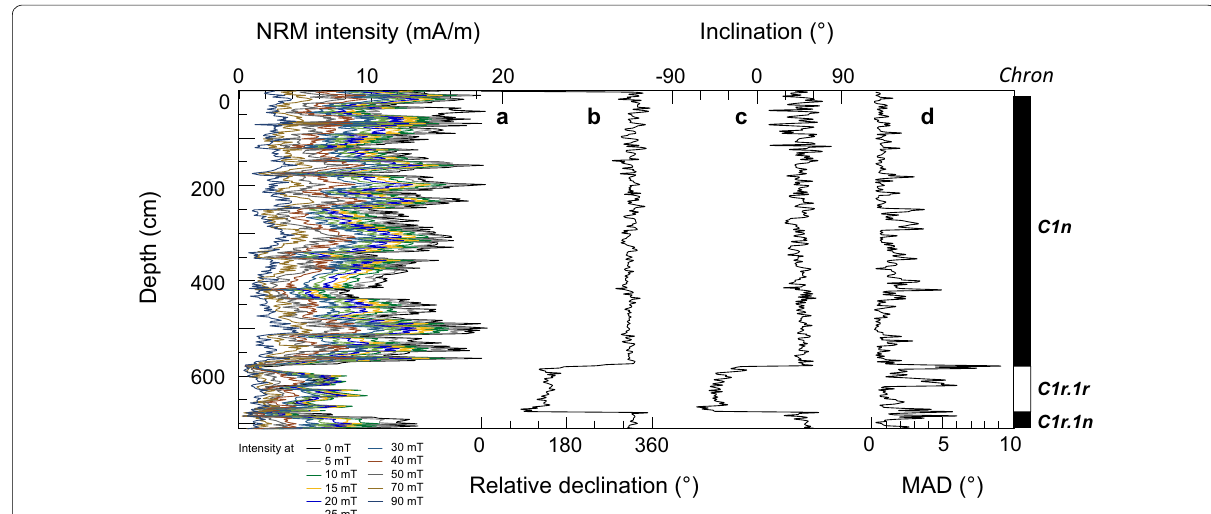
Fig. 3 Down-core variations in a natural remanent magnetization (NRM) intensity at each AF demagnetization step, b declination and c inclination of characteristic remanent magnetization (ChRM) directions, and d maximum angular deviation (MAD). The reference magnetic polarity is indicated on the right side of the figure